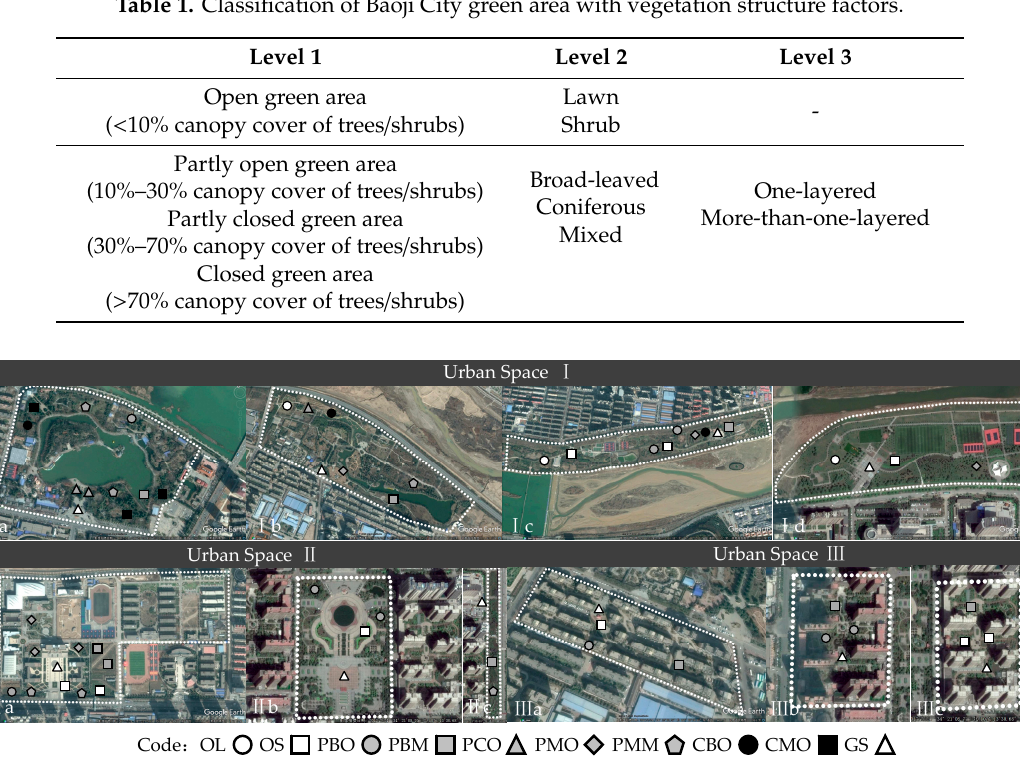
Table 1. Classification of Baoji City green area with vegetation structure factors.